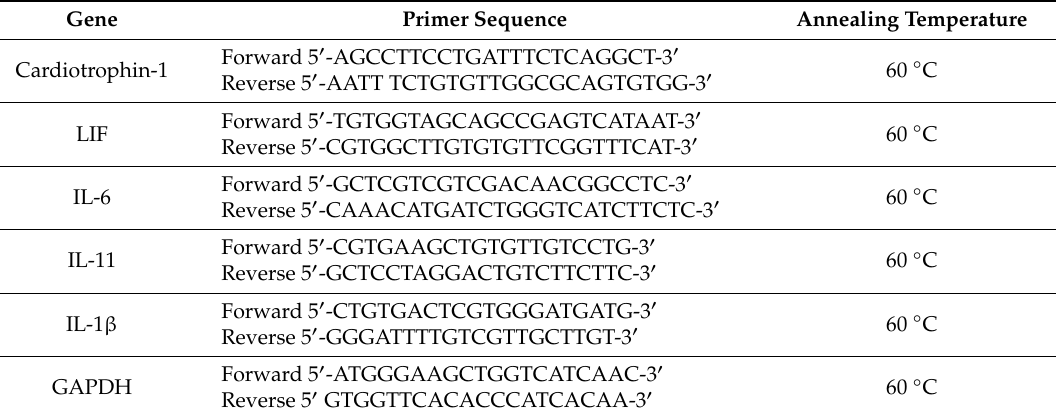
Table 1. Primer sequences used for